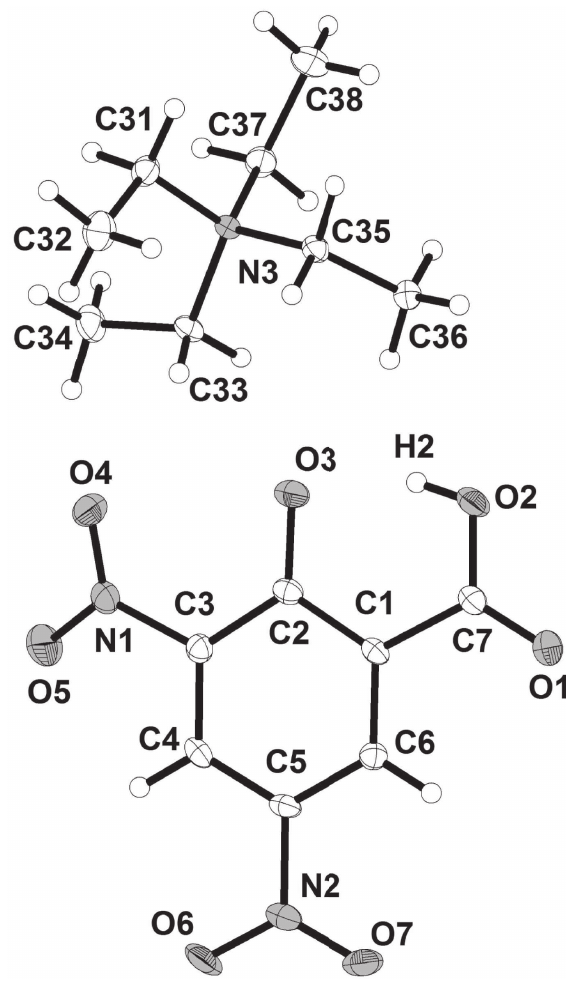
Figure 1: Molecular diagram of the title compound. Thermal ellipsoids shown at a 50% probability level.